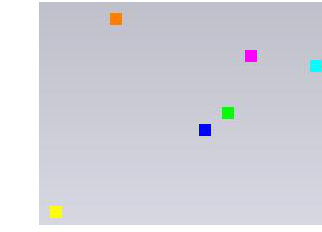
Figure 2. Distribution of points as result of repeated measurements belonging to 1/2 scan resolution In Figure 2, yellow point means 1 st scan, light green point means 2 nd scan, cyan point means 3 rd scan, blue point means 4 th scan, purple point means 5 th and 6 th scan is represented by orange